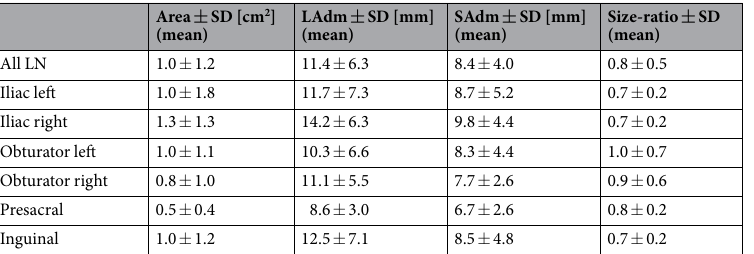
Table 2. Characteristics of all PET-positive lymph nodes depicted in MRI using T1 combined with T2 and DWI-sequences. This table presents the main characteristics of all malignant lymph nodes (LN) depicted in 68 Gallium-Prostate specific membrane antigen PET-CT and MRI. Area, long-axis diameter, short-axis diameter and size ratio of the LN are presented in the columns. The size ratio is described as quotient of short-axis diameter divided through long-axis diameter. The rows show all LN together and fielded in the six defined anatomical regions iliac left and right, obturator left and right, presacral and inguinal region. Data are given in means and standard deviations. Abbreviations: LN = Lymph nodes, LAdm = Long-axis diameter, SAdm = Short-axis diameter, SD = Standard